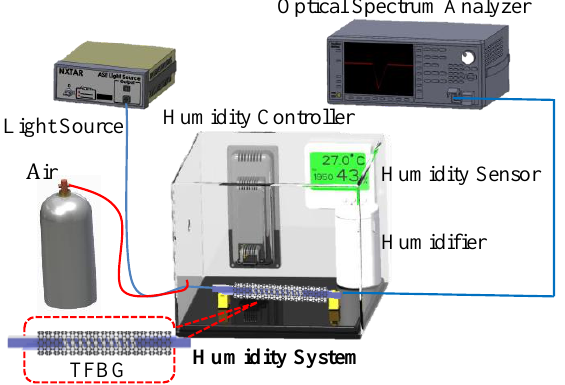
Figure 4. Experimental setup for humidity sensing.